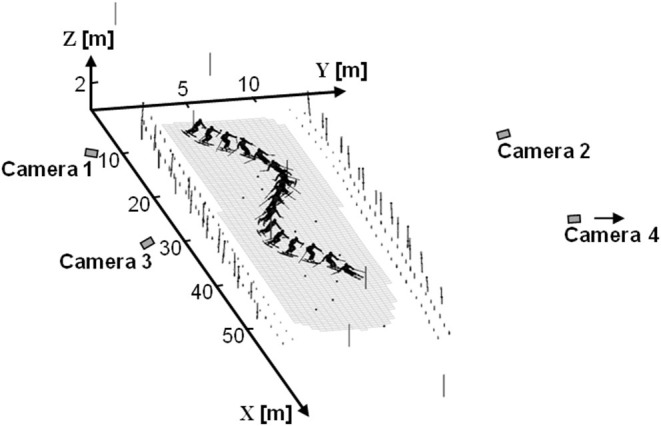
A graphical reconstruction of the experimental set-up. Control point positions are indicated by the small points and poles. Note that camera 4 was actually placed 30 m further to the right as seen from this perspective.